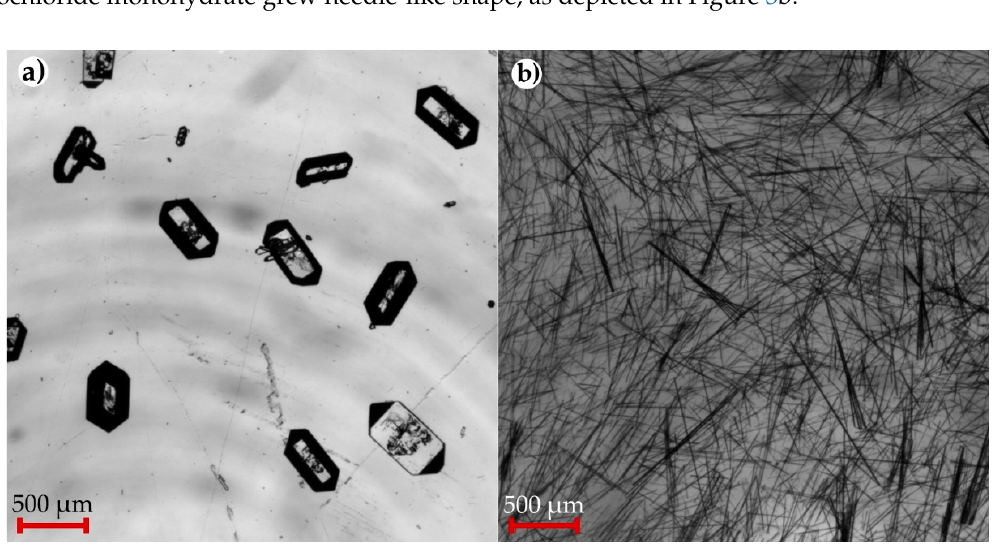
Figure 3. ( a ) KH 2 PO 4 crystals; ( b ) Thiamine hydrochloride monohydrate crystals captured by the shadowgraphic probe during the experiments.